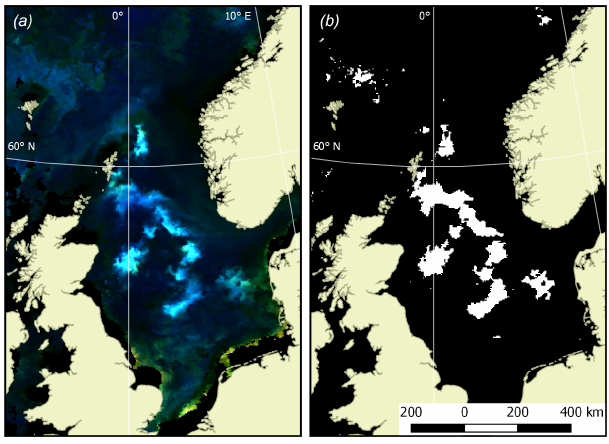
Figure 1. Example of the bloom masking algorithm performance. (a) Source of the OC CCI RGB imagery for the North Sea (9 June 2016, with land mask); (b) calculated bloom mask (white pixels stand for bloom detected, black pixels are areas void of